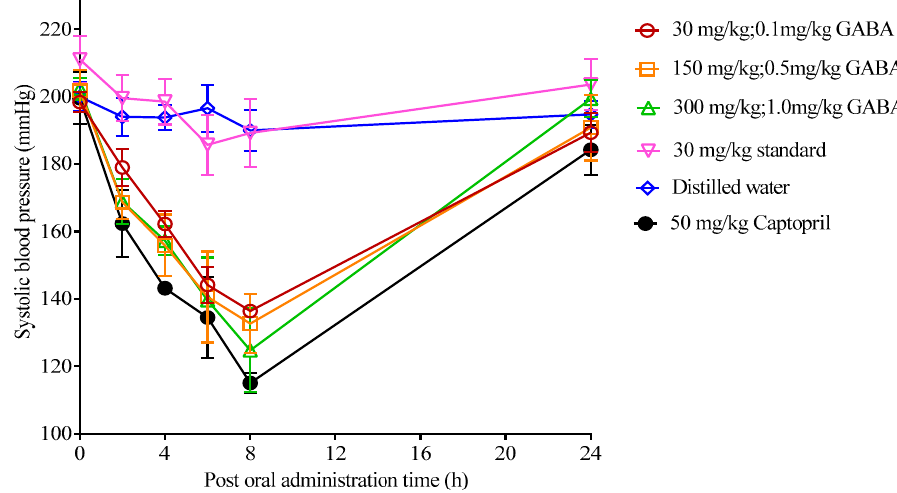
Figure 4. Mean systolic blood pressure of spontaneously hypertensive rats within 24 h of single oral administration of 30, 150, and 300 mg / kg yogurt (consisting of 0.1, 0.5, and 1.0 mg / kg GABA, respectively) compared to 30 mg / kg standard yogurt, 50 mg / kg captopril, and distilled water.